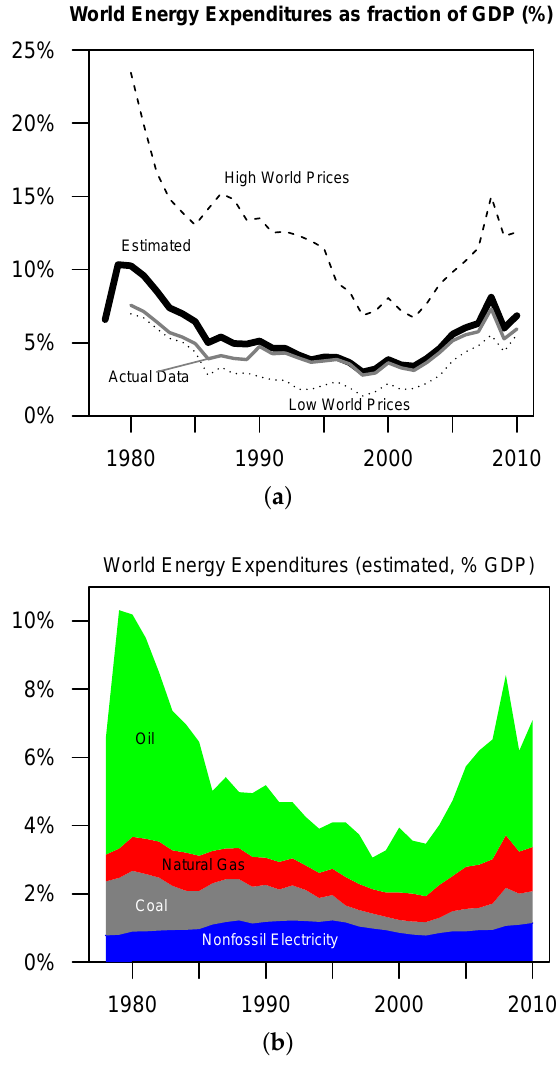
Figure 2. ( a ) Total energy expenditures divided by GDP, f e ,GDP , for the 44 countries in the dataset from 1978–2010; ( b ) expenditures on energy divided by GDP, f e ,GDP (for the 44 countries in the dataset), per commodity, using the “estimated” calculation. Actual data = using “actual” data as reported in the IEA dataset (no substitutions for missing data). Estimated = assumes prices for countries with no price data for certain commodities (see the Supplemental Information). “Low/high world prices” = assumes the lowest/highest price in the dataset for each commodity in each year is applied to all